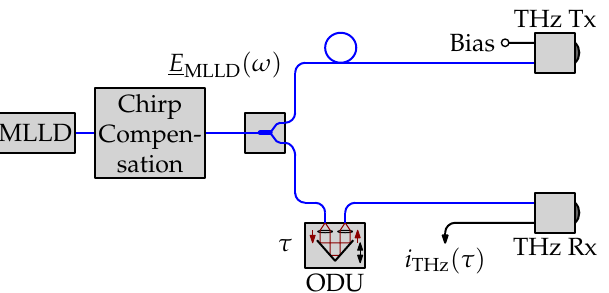
Figure 1. Simplified block diagram of a UHRR-THz-TDS system. Blue lines indicate polarization maintaining fibers. Black lines indicate electrical